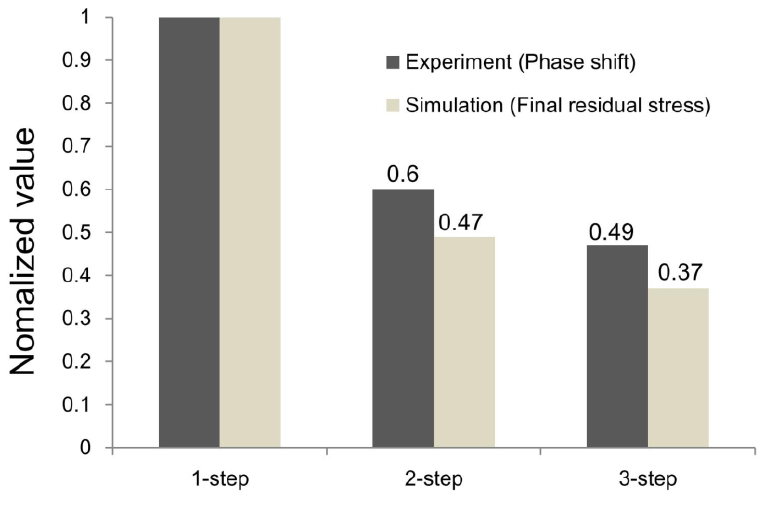
Figure 11. Comparison of normalized value between experiment and